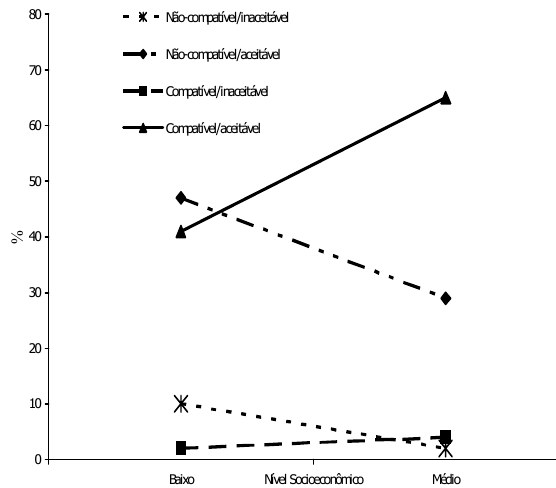
Figura 1. Categorias simultâneas de respostas em função do nível socioeconômico.